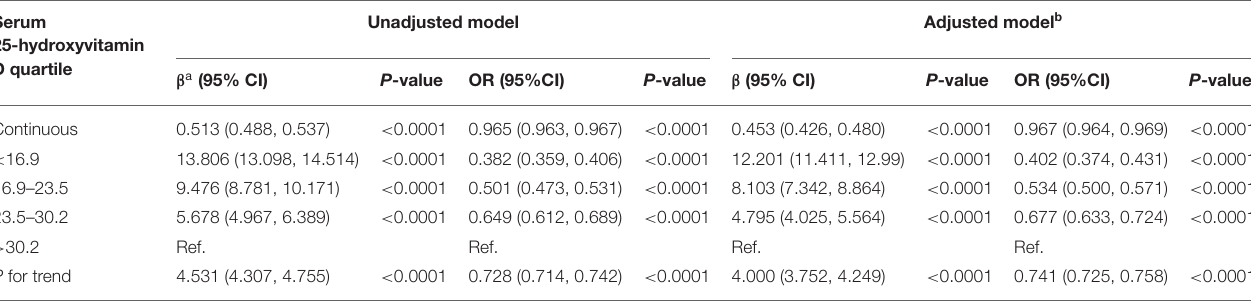
TABLE 2 | Association between vitamin D levels and kidney function. Serum